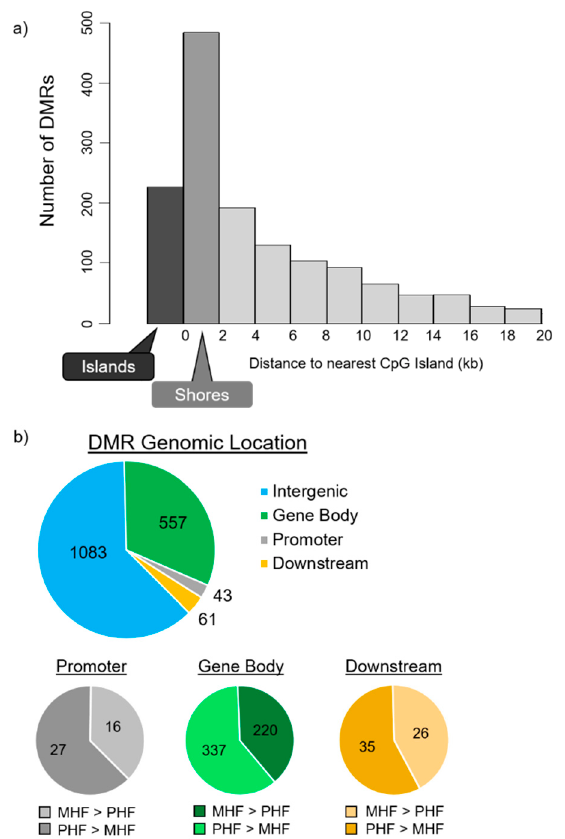
Figure 3. DMR distributions in relevance to CpG islands and to gene locations and structures. ( a ) DMR distribution around CpG islands. CpG shore was defined as the 2000 base pair sequence flanking either side of a CpG island. DMRs in the shores (dark gray, n = 484) outnumbered the DMRs located within CpG islands (black, n = 227). ( b ) DMR locations relative to gene structures. Promoter and downstream regions were defined as ± 1500 bp upstream of the transcription start site and downstream of the transcription end site, respectively. Top panel depicts the number of DMRs not associated with a gene (blue, n = 1083) and DMRs located within the gene body (red, n = 557), within the promoter (gray, n = 43), and within the downstream region (yellow, n = 61). A majority of DMRs are not associated with protein-coding genes. Bottom panels classify the DMRs within the promoter, gene body, and downstream regions. DMRs that are more methylated in MHF (MHF > PHF) are in darker shades, while those that more methylated in PHF (PHF > MHF) are in lighter shades.